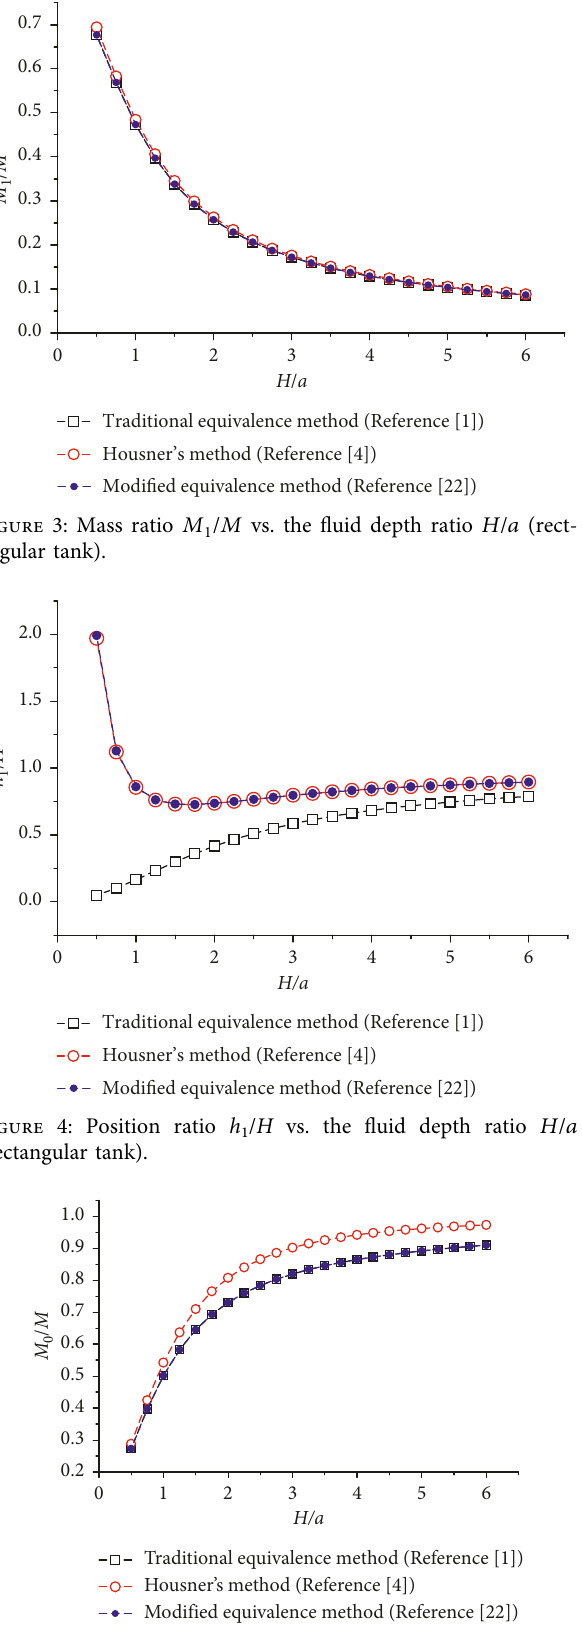
/ M vs. the fluid depth ratio H / a (rect- 0